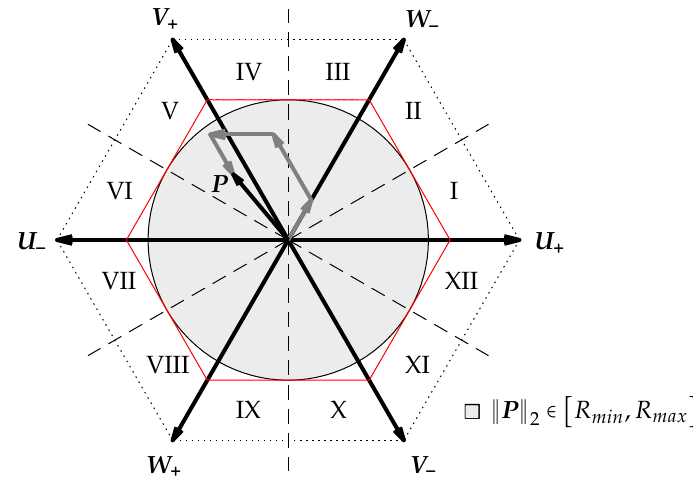
Figure 9. 4-Active SVM: The space vector P is formed by the negative ( U − , V − , W − ) fundamental space vectors and V + for an enhancement of the modulation amplitude ( t INF =